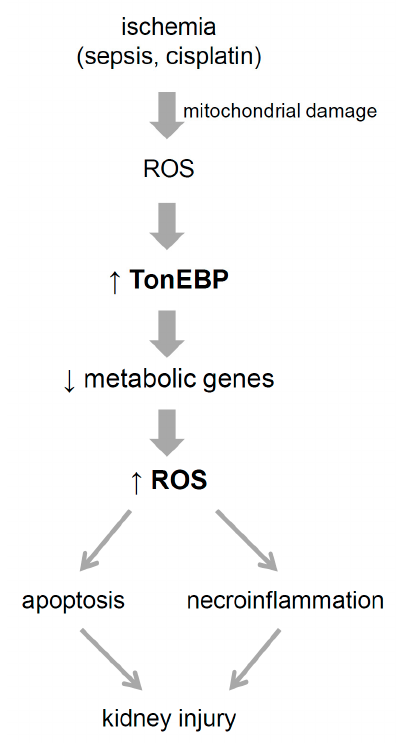
Figure 11. Model for the role of TonEBP in acute kidney injury. Mitochondrial damage in response to ischemia (as well as sepsis and cisplatin) leads to the production of reactive oxygen species (ROS) in addition release of cytochrome c and mitochondrial DNA in renal tubules. Induced by ROS, TonEBP promotes further ROS production via suppression of genes involved in cellular pathways including peroxisome, mitochondrial inner membrane, PPAR signaling, and glycolysis/gluconeogenesis. ROS causes apoptosis and necorinflammation (cell death and inflammation) in tubular cells leading to functional kidney injury. See text for details.